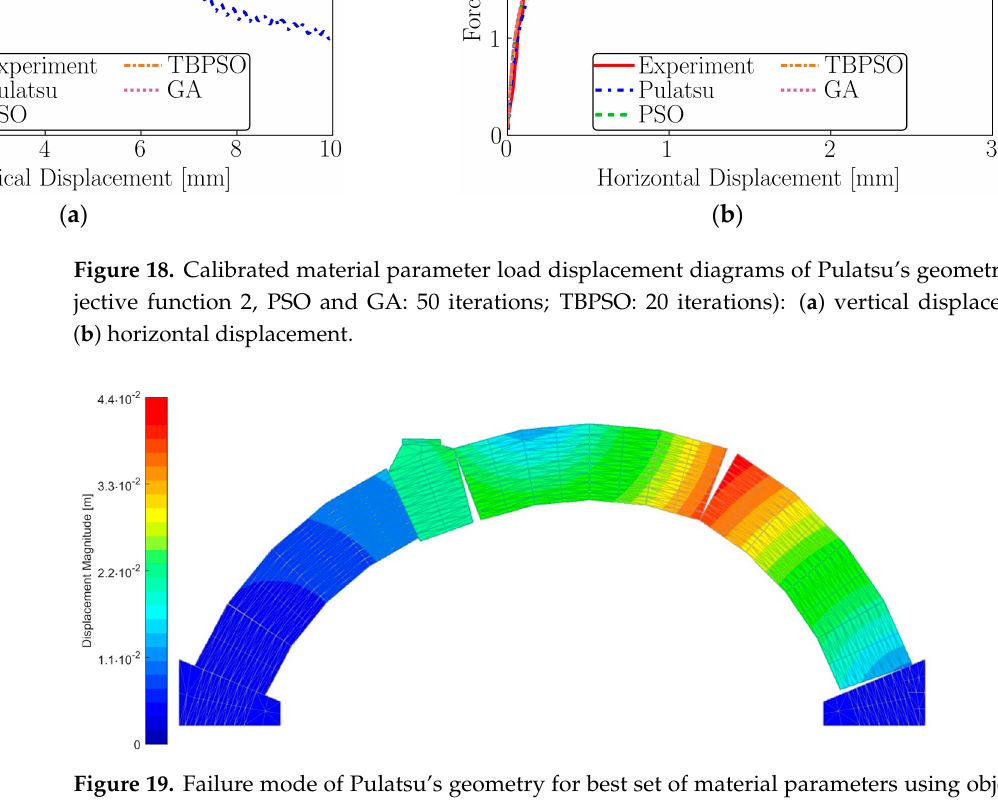
function 2; the colour legend represents the displacements in metres.